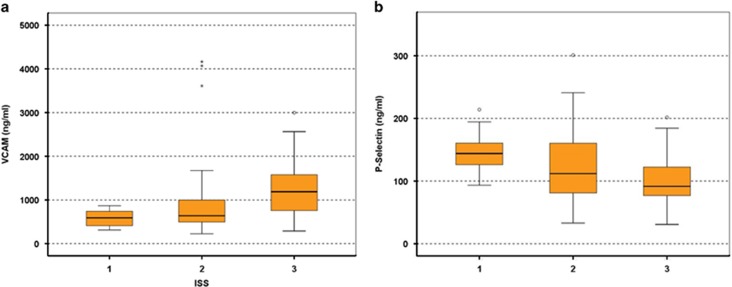
Correlation of VCAM (a) and P-selectin (b) with ISS stage: VCAM-1 was lower in NDMM patients with ISS-1 compared to patients with ISS-2 and ISS-3 (ANOVA P=0.002; a); P-selectin was higher in ISS-1 compared with ISS-2 and ISS-3 NDMM (ANOVA P=0.001; b); whisker plots (open circles) refer to outlier values, while 'extreme' values are marked with an asterisk.